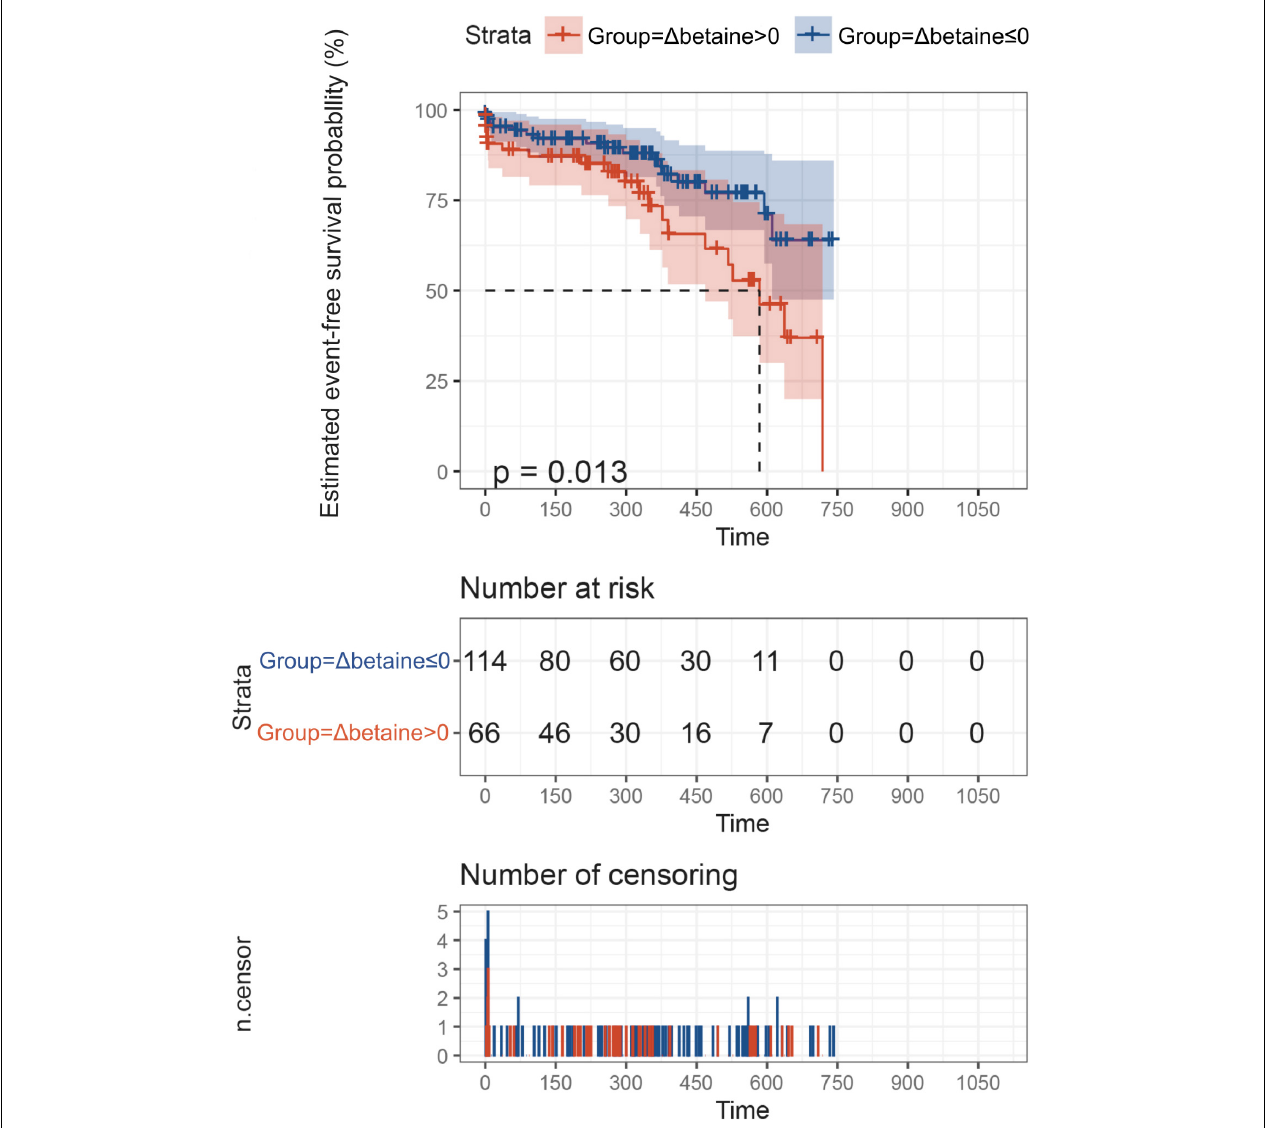
FIGURE 4 | (cid:49) Betaine was associated with the prognosis of patients with PH. Patients were divided into two groups according to (cid:49) betaine > 0 or (cid:49) betaine ≤ 0. Follow-up duration was defined from the second betaine measurement to the occurrence of outcomes or the end of follow-up. In this analysis, outcome events occurred in 23 patients between two measurement points, so these patients were excluded. Finally, a total of 180 patients with PH were included for exploration. Value of p calculated by the log-rank